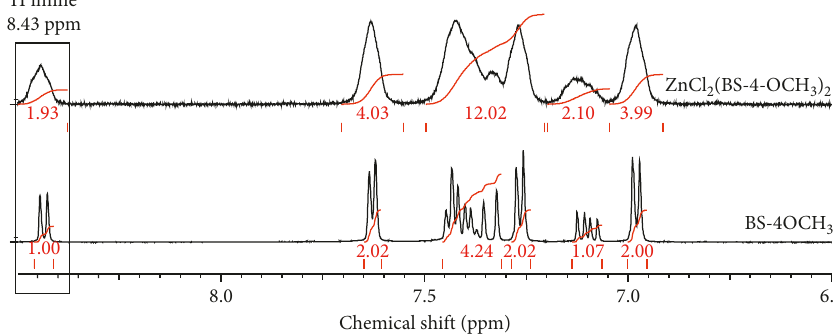
Figure 3: 1 H NMR spectra of the uncomplexed BS-4-OCH